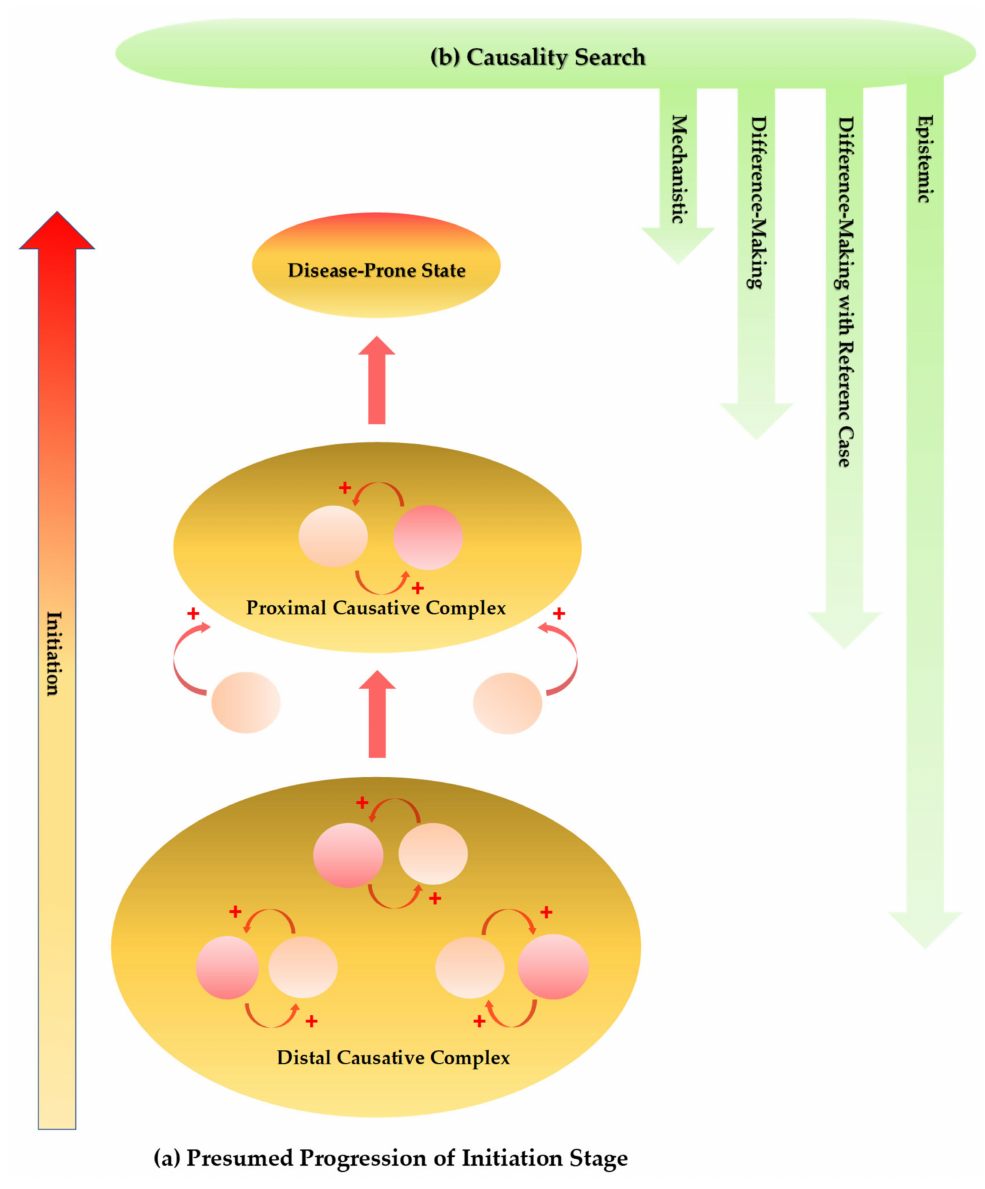
Figure 5. Presumed progression of initiation stage and approaches for causality search of multifactorial neurodegenerativediseases.( a )Thegenetic,environmental,infectious,nutritional,andlifestylecomponents are major factors in the initiation process. The cause–effect relationships can become bidirectional. A cause becomes an effect and an effect becomes a cause, playing an initiation role in multiple reciprocal causations. Constantly changing numerous factors form an effective causative complex.The distal causative complex influences and develops the proximal causative complex in progression of the initiation phase, leading ultimately to a disease-prone state. ( b ) The causal assessment is performed by multi-causality and probabilistic determinism establishing classical causal criteria. Mechanistic and difference-making interpretations inform causality assessment. Incorporation of a reference case may ease reaching an interpretation of meaningful comparisons. The epistemic causality search assesses evidence which cannot be reducible by mechanistic and difference-making